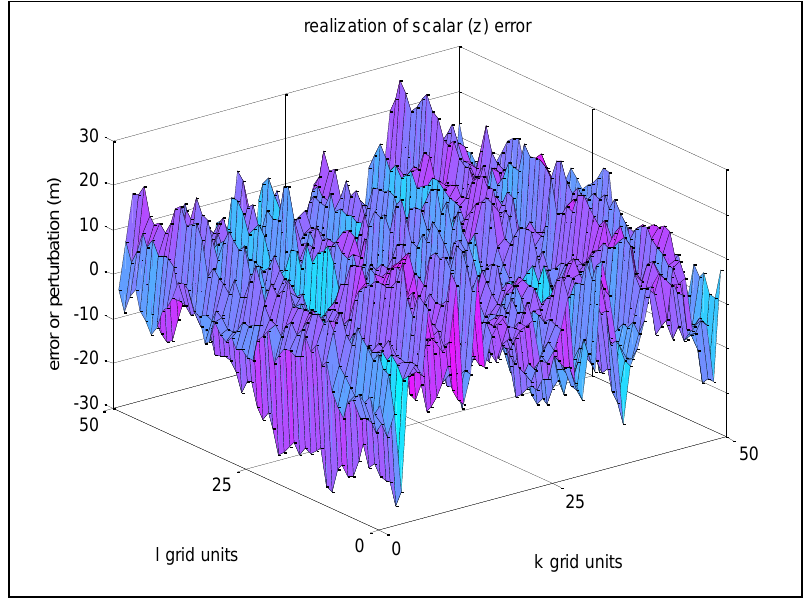
Figure 8. Sample statistics corresponding to 1000 × 1000 grid with different a priori